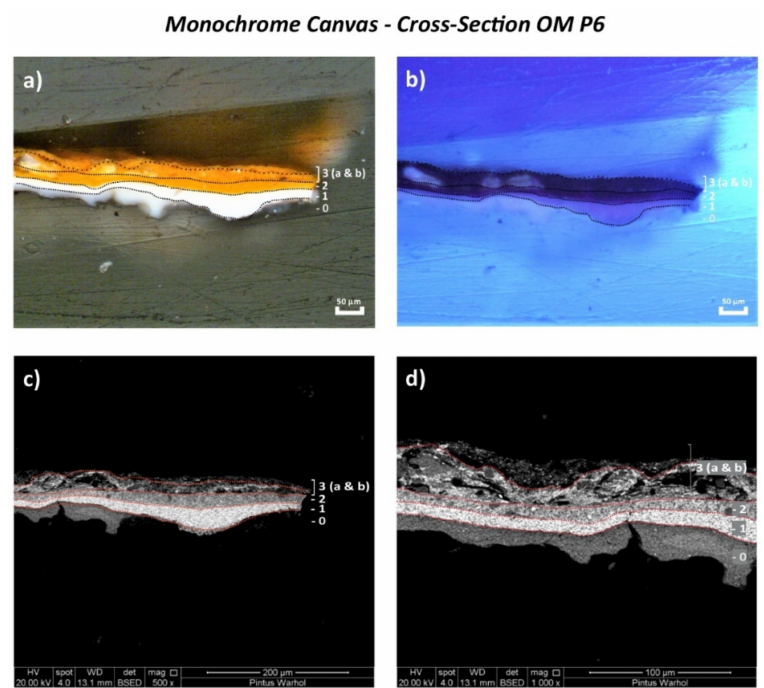
Figure 3. ( a ) Optical microscopy image of the cross-sectioned OM P6 sample under reflected visible light (Vis) showing the main layers and ( b ) under ultraviolet light (UV). ( c ) SEM micrograph of the whole cross-sectioned OM P6 sample and ( d ) detail of the area investigated by bulk-area EDX analyses showing the main paint layers.